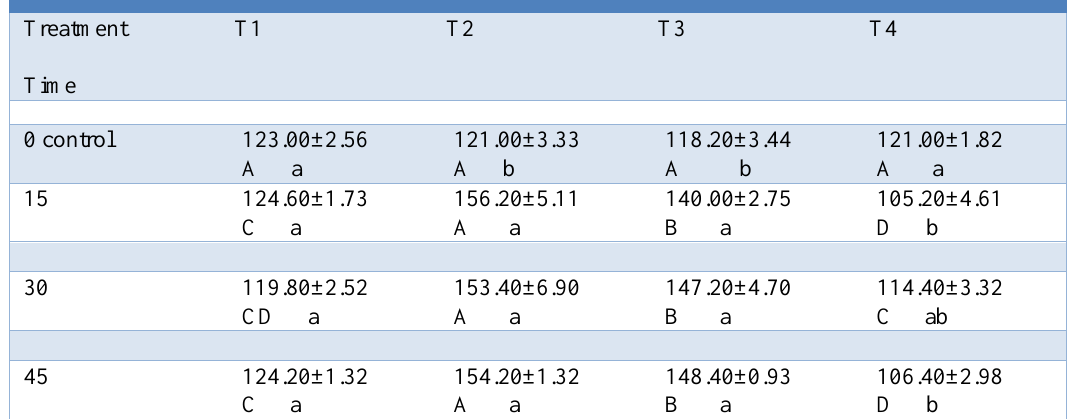
Table, 3: Effects of Salvia Officinal's (SO) and Salvia officinal's Silver Nanoparticles (SOSNP) on serum reduced glutathione (GSH) concentration (μmol/L) in normal and methotrexate (MTX) treated rats LSD= 12.90